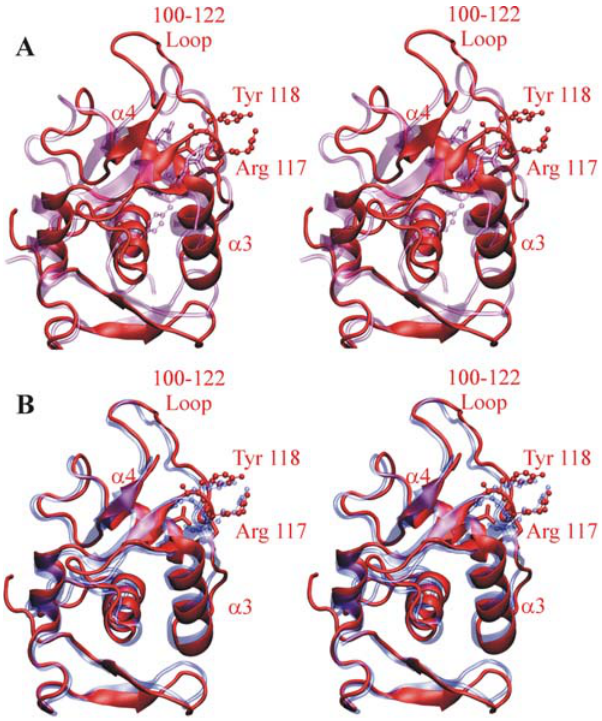
Figure 3. Structural comparison between active sites of topoisomerases from gram-positive and gram-negative bacteria. (A) Stereo view of the superposition of the active site of ParC from S. pneumoniae (red) and ParC from E. coli (violet). (B) Stereo view of the superposition of the active sites of ParC from S. pneumoniae (red) and GyrA from E. coli (blue). The active-site tyrosines and arginines are represented in CPK mode. Sites responsible for drug-resistance when mutated are represented in Licorice mode. Panels were rendered using VMD [50] and Pov-Ray.